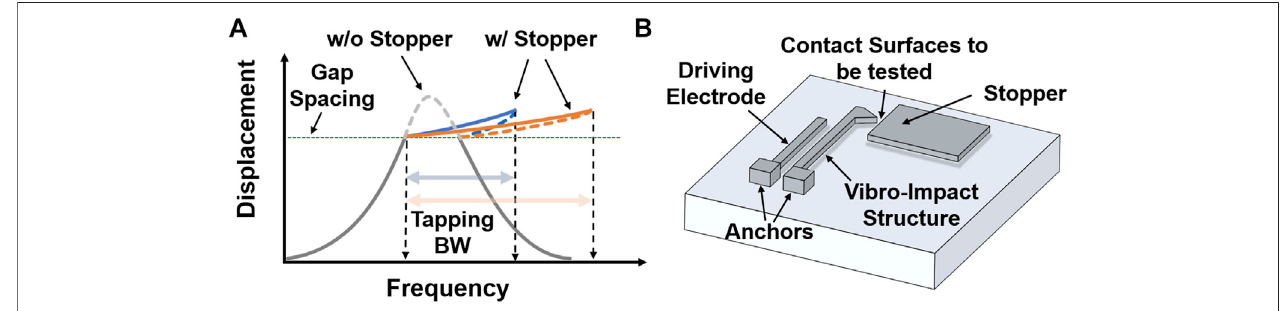
FIGURE6|(A) Illustration ofthefrequencyresponsesofvibro-impactresonators showingthetappingbandwidth de fi nition. (B) Illustration ofhowthevibro-impact resonators can be used for on-chip condition examination of the contact surfaces.